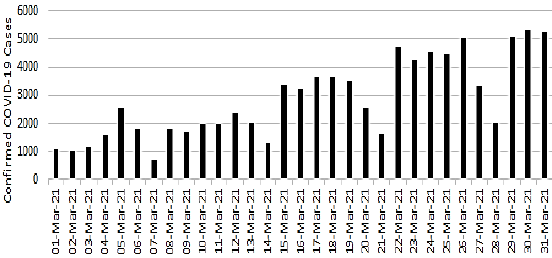
Figure 6. Daily cases in NCR from 03/01 to 03/31,